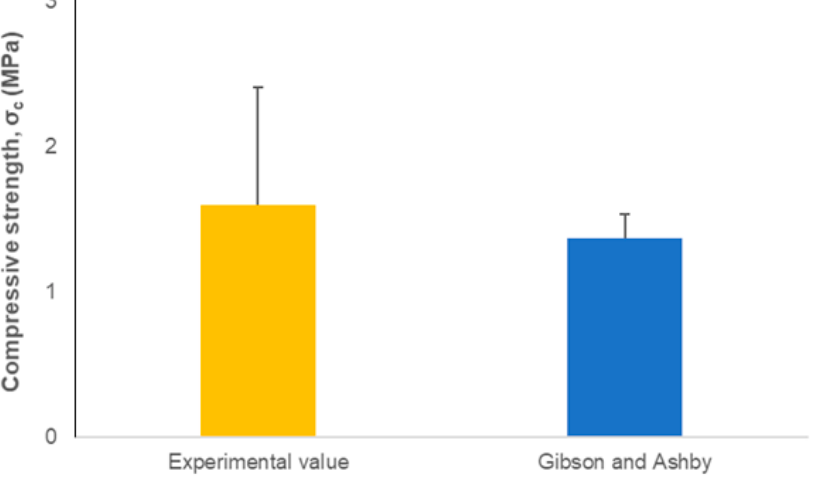
Figure 3. Compressive strength: comparison between the results from Gibson–Ashby model and experimental data ( n = 20, p < 0.05).